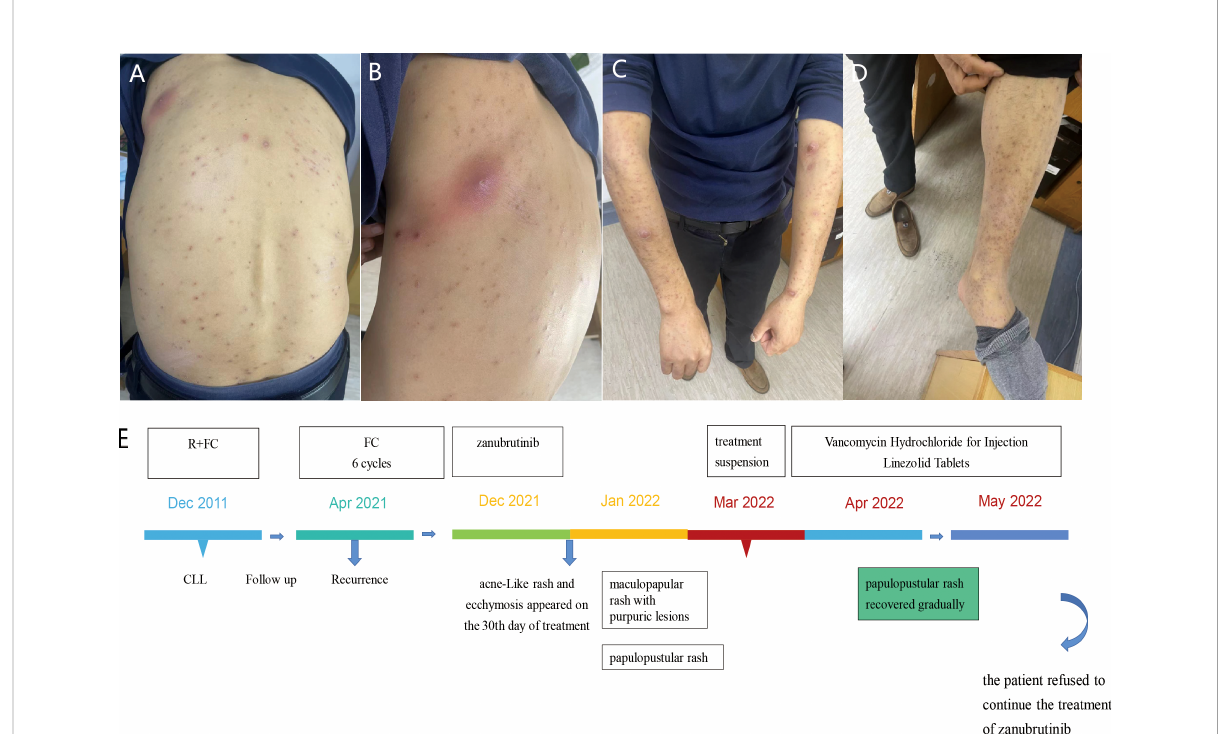
FIGURE 2 Case 2 : A 56-year-old man with CLL. (A, C, D) difused and severe maculopapular rash with purpuric lesions on the trunk, upper extremity and lower extremity. (B) necrotizing folliculitis with suspected Staphylococcus aureus superinfection on the back. (E) The time line of this